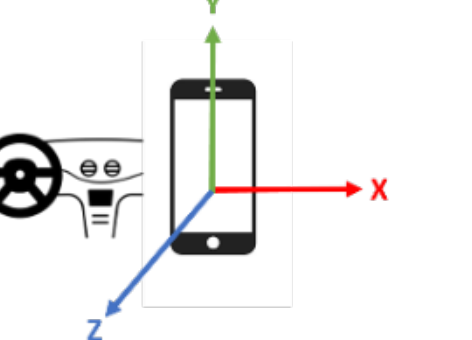
Figure 1. Phone orientation inside the vehicle where X, Y, and Z represent the space dimensions.